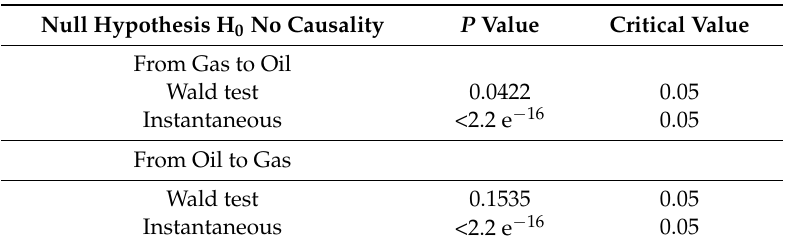
Table 2. Full sample causality